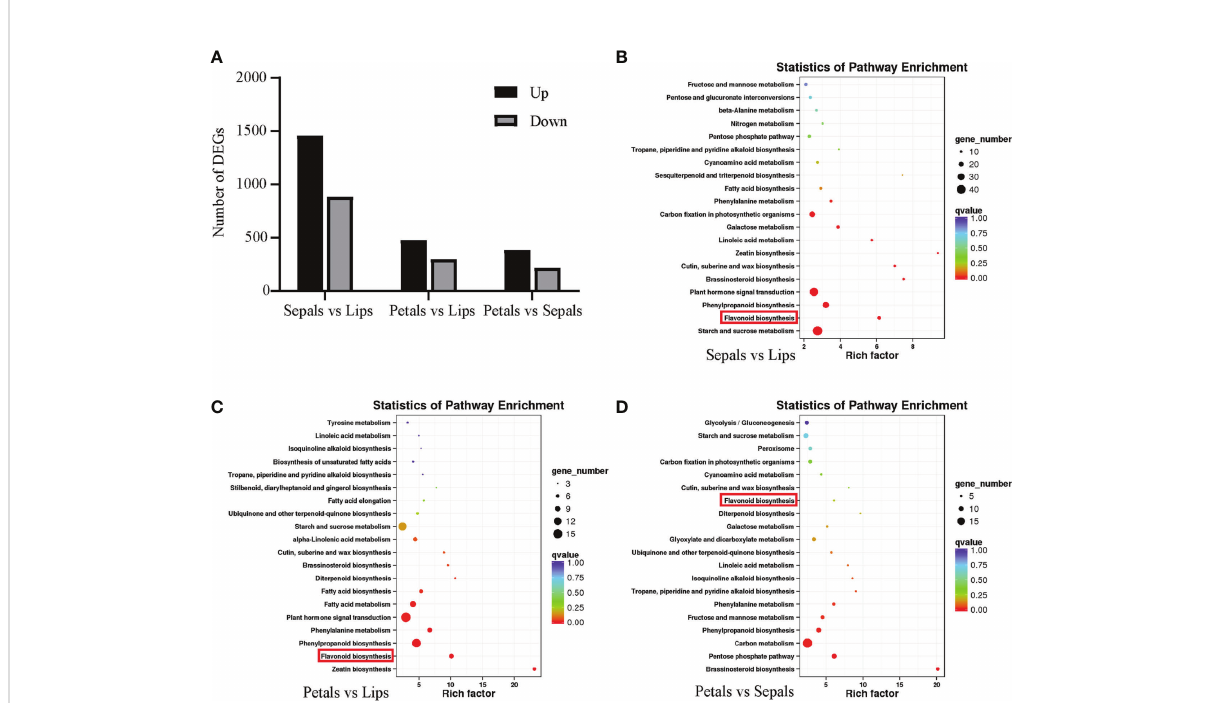
FIGURE 2 KEGG pathway enrichment analyses of DEGs of different fl oral tissues of D. ‘ Suriya Gold ’ . (A) Number of DEGs upregulated and downregulated in each comparison. KEGG pathway enrichment scatter plots of DEGs in each comparison: Sepals vs Lips (B) , Petals vs Lips (C) and Petals vs Sepals (D) . Top 20signi fi cant pathways involving DEGs are included, with the fl avonoid metabolism pathway highlighted with red rectangles.